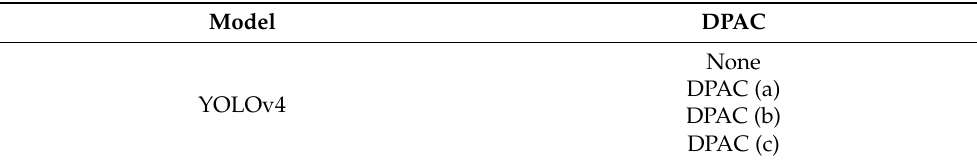
Table 4. Design of the DPAC